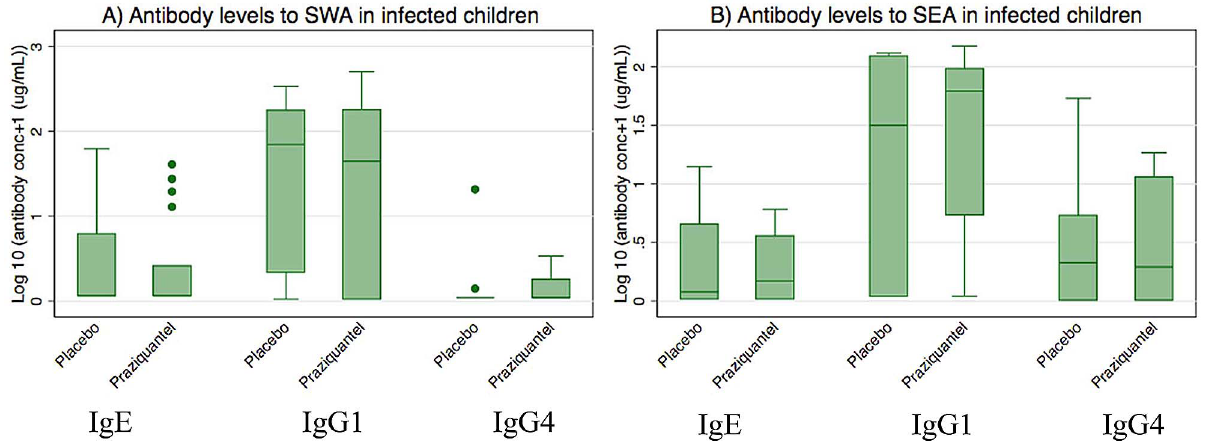
Figure 4. Effect of praziquantel treatment of women during pregnancy on levels of antibodies to SWA or SEA among their offspring having S.mansoni at age 5 years. Shown are plasma levels of antibodies to SWA (A) or SEA (B) among children that had S mansoni infection at age five years.